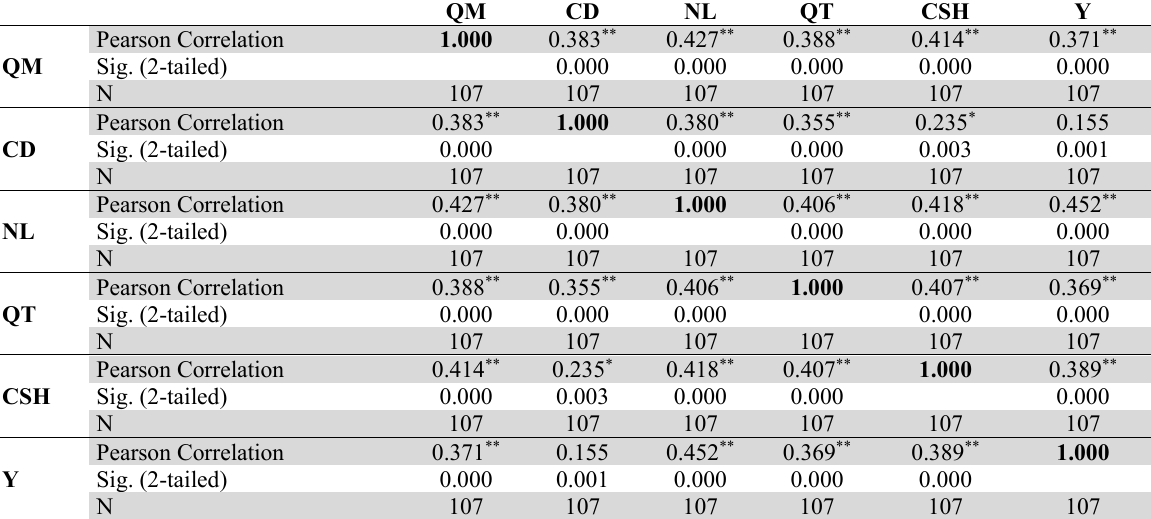
Pearson Correlation Analysis results